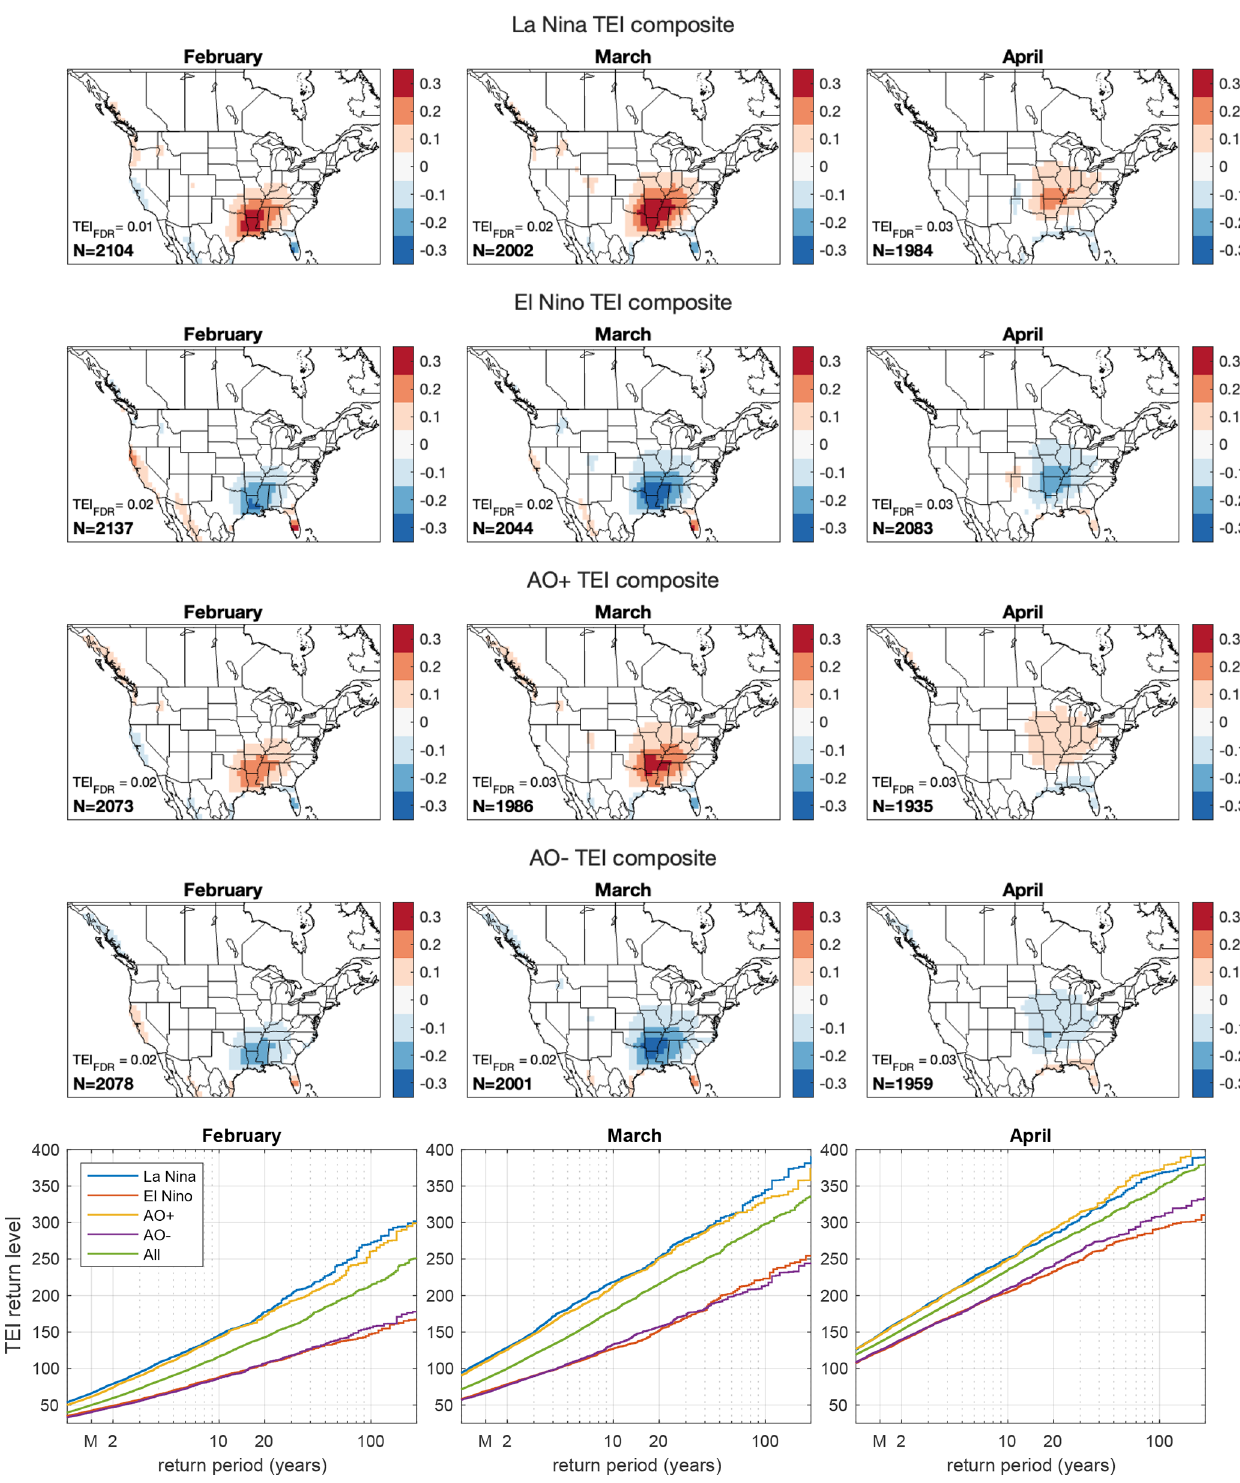
Figure 1. Rows 1–4: univariate Niño 3.4 and AO composites of February, March, and April TEI anomalies. TEI units are number of tornado reports per 1 × 1 grid box. The sample size for each case is indicated in the lower left corner. All statistically insignificant values have amplitudes less than TEI FDR , which is shown on each map. Statistically insignificant values and values with absolute values less than 0.05 are masked. Bottom row: summed (land points east of 110 ◦ W) TEI return levels and approximate return periods conditional on univariate Niño 3.4 and AO phases. “M” marks the approximate return period of the